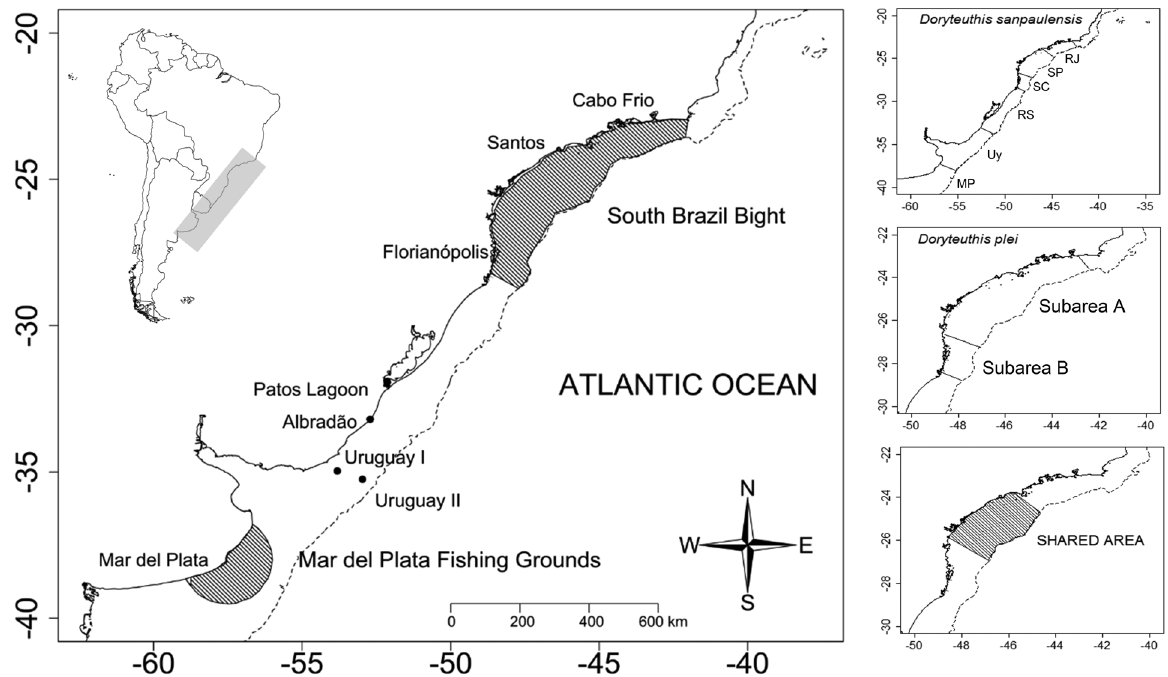
Figure 1. Study area, showing the areas and sites from where squid samples were obtained, also including the subareas used for the geo- graphic differentiation in Doryteuthis sanpaulensis and D. pleii plus the shared area of co-occurrence of both species. The relative position of the study area on the South American Atlantic coast is boxed. RJ: Rio de Janeiro, SP: São Paulo, SC: Santa Catarina, RS: Rio Grande do Sul, Uy: Uruguay, MP: Mar del Plata. Subarea A: Cabo Frio (23°S) – Paranaguá (26°S), Subarea B: Paranaguá (26°S) – Santa Catarina Island (28°S). Latitudes and longitudes are decimal transformed. The 200 m isobath is showed (dashed line).